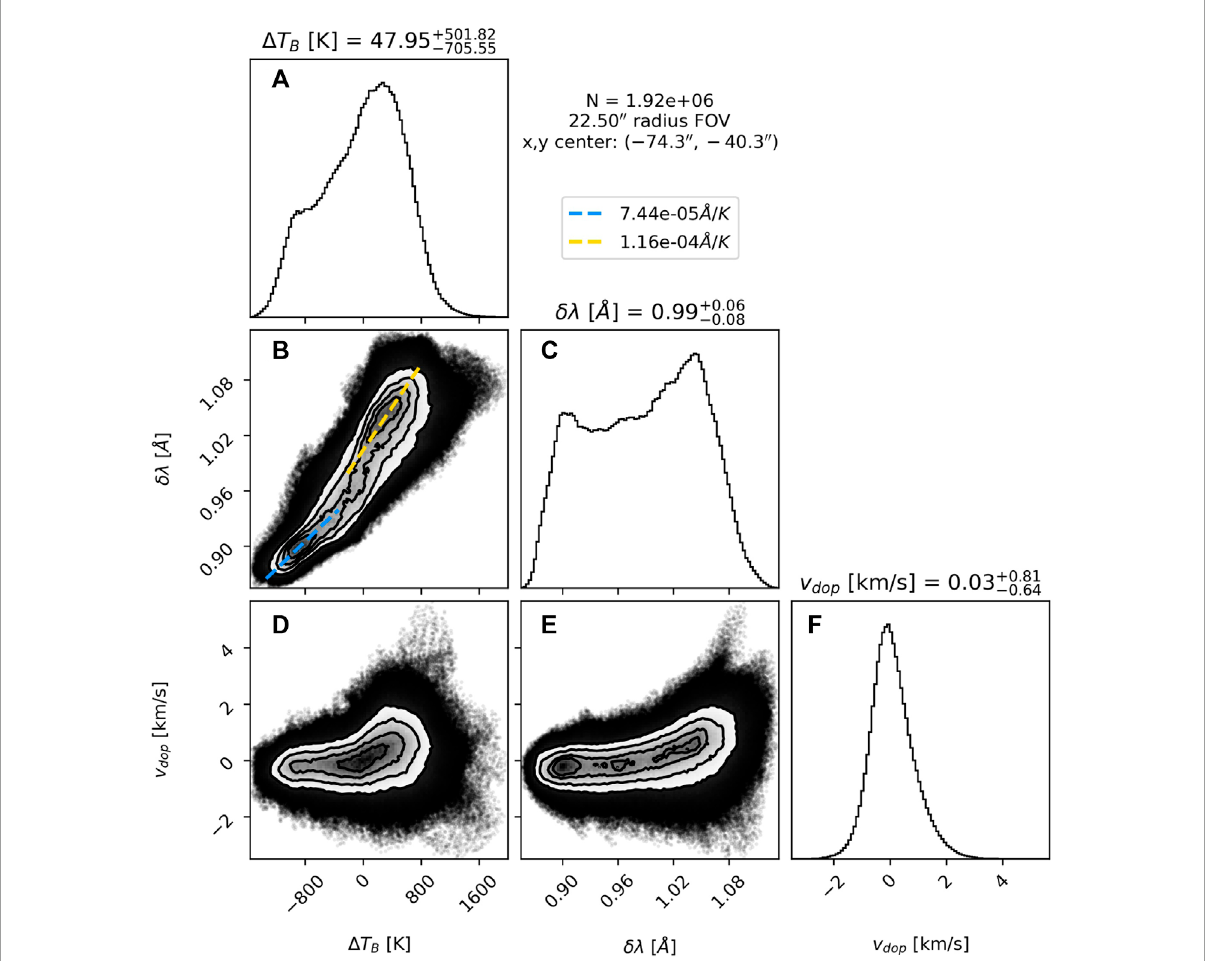
FIGURE 4 1D distribution for the relative Band 3 brightness temperature (A) , H α line width (C) , and H α Doppler velocity (F) , and the 2D joint distributions for ( Δ T B , δλ ) (B) ( Δ T B , v dop ) (D) , and ( δλ , v dop ) (E) , generated from pixels within a 22 . 5 ′′ radius from the ALMA beam center. The distributions contain a total of 1 . 92 × 10 6 pixels over the 685 joint time steps { t O } . The contours in the joint distributions mark the 20 % quintiles, e.g., 20 % of the data is between each contour, and the remaining 20 % (or 3 . 8 × 10 5 pixels) are in the outer cloud of individual points. The blue (yellow) dashed lines show fits to the cores of the cooler (hotter) regions. The zero point of the ALMA temperature scale is the average over the data and should be close to the value of 7300 K reported by White et al.